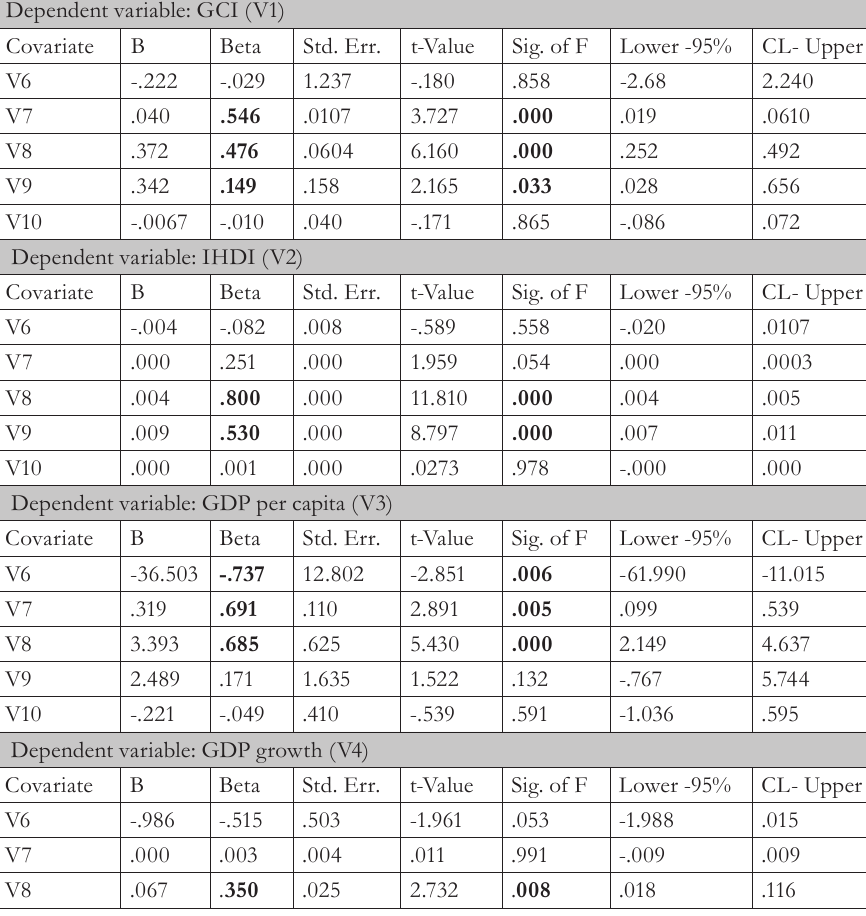
Tab. 7 – Regression analysis for cells error term. Source: own